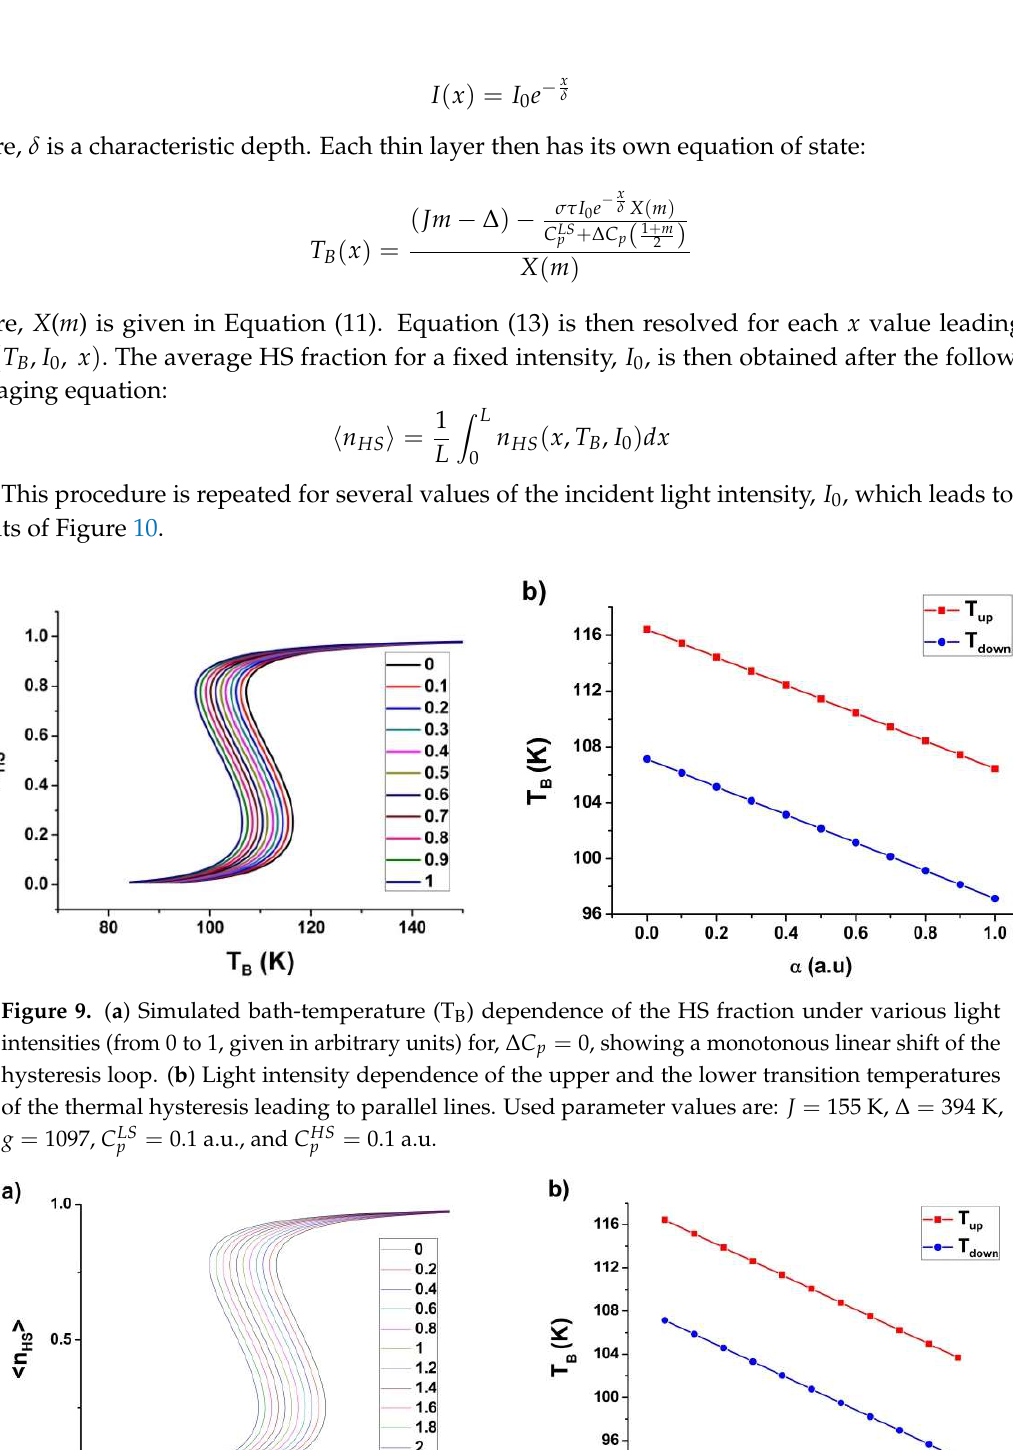
Figure 8. ( a ) Simulated bath-temperature ( 𝑇 (cid:3003) ) dependence of the HS fraction under light causing its photo-heating for various light intensity values, given in arbitrary units. ( b ) Light intensity dependence of the upper and lower transition temperatures of the thermal hysteresis. Parameter values are: 𝐽 = 155 K , Δ = 394 K , 𝑔 = 1097 , 𝐶 (cid:3043)(cid:3013)(cid:3020) = 0.1 a.u, and 𝐶 (cid:3043)(cid:3009)(cid:3020) = 0.01 a.u. (arbitrary units).